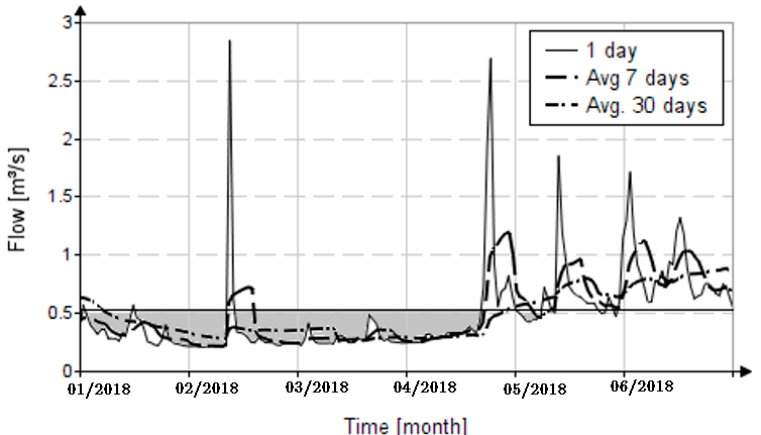
Figure 2. Determining drought volumes and durations for the Q 80% threshold.